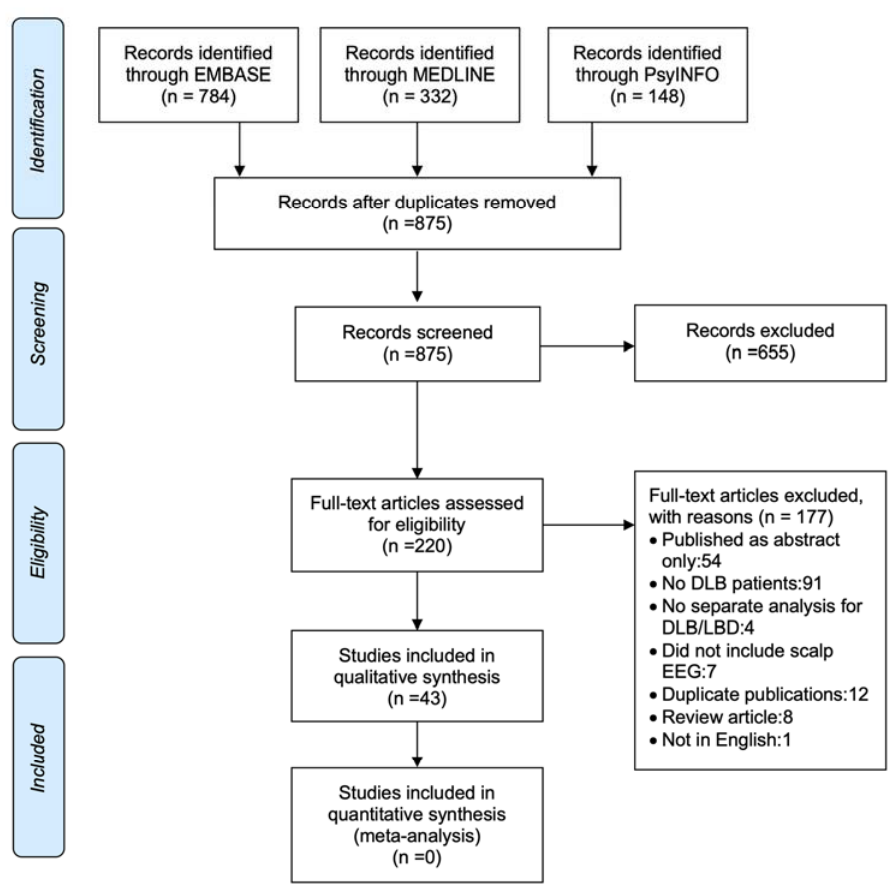
Figure 1. PRISMA flow diagram of study